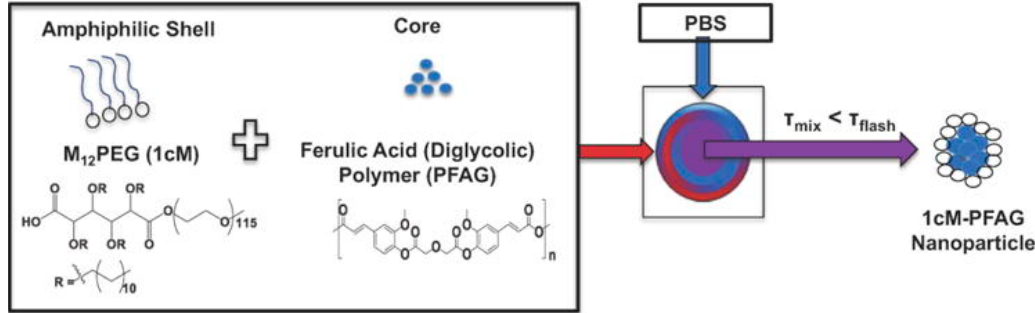
Figure 4. Description of the flash nanoprecipitation process for the formulation of the nanoparticles. Reprinted with permission from Acta biomaterialia. Chmielowski, R.A., et al., Athero-Inflammatory Nanotherapeutics: Ferulic Acid-based Poly(anhydride-ester) Nanoparticles Attenuate Foam Cell Formation by Regulating Macrophage Lipogenesis and Reactive Oxygen Species Generation, pages 85–94. Copyright 2018 [49].